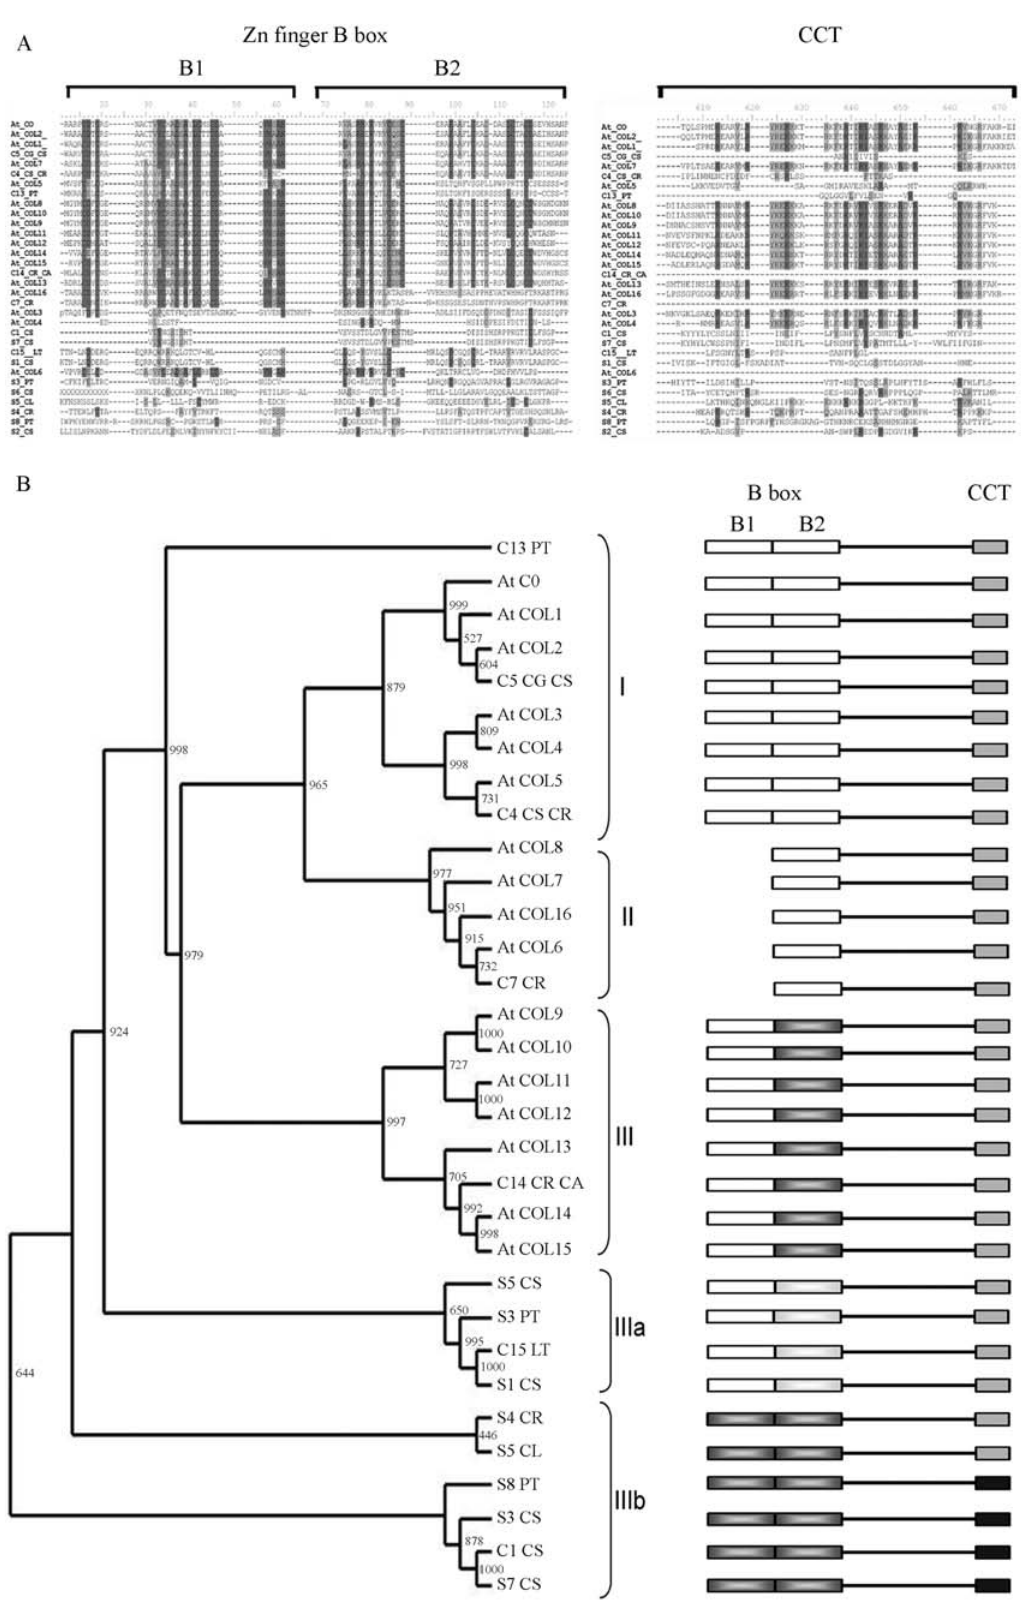
Figure 5 - CONSTANS family in citrus. A. Alignment of predicted B-box and CCT peptide domains of CONSTANS and related genes from Arabidopsis and citrus. The shaded residues represent conserved C residues and consensus spacing defining B-box